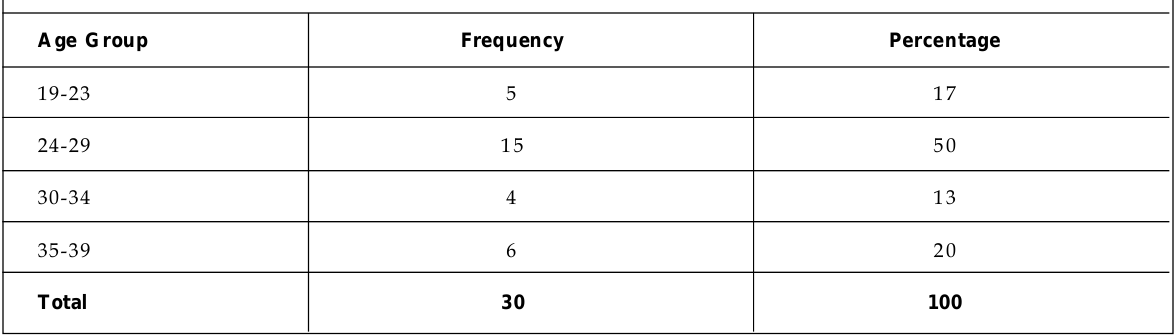
Table 1: Demographic characteristics of women suspected to have chorioamnionitis Age